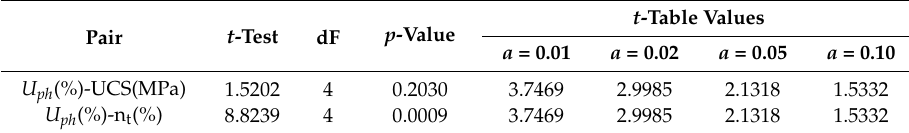
Table 3. Paired t -test results for the statistical correlations of the indices U ph and UCS , n t . The listed critical t -table values are for the relevant freedom degrees (dF) and for confidence levels of